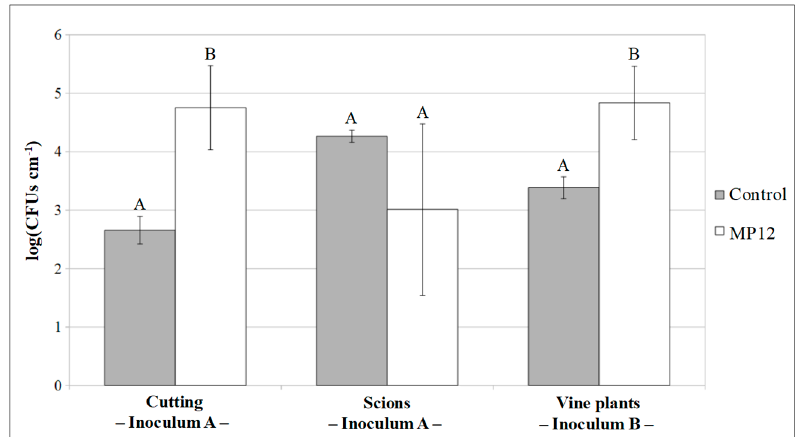
Figure 3. Values of the cell counts in the first internode of cuttings, scions (inoculum A), and vine plants (inoculum B) after endophytic inoculation. Mean and standard deviation of 10 plant samples were considered. Mean values marked by the same letter are not significantly different at p < 0.05.